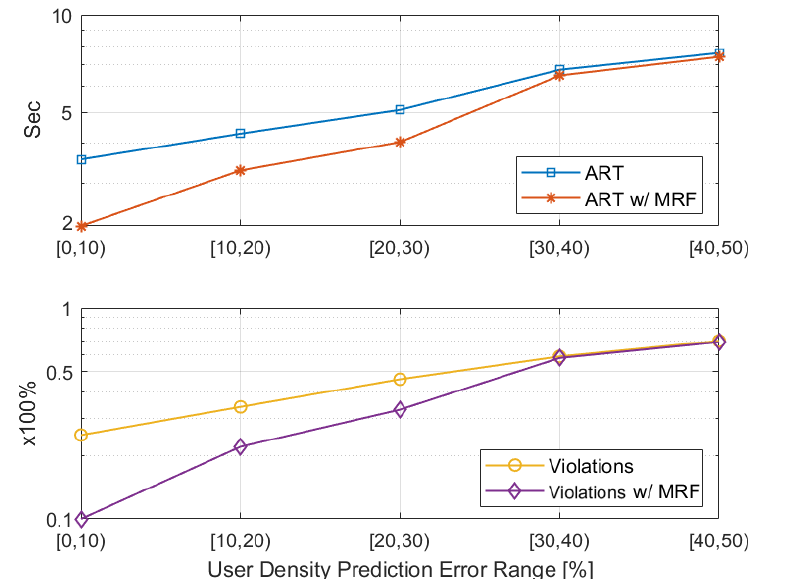
Figure 6. ART & QoS violations sensitivity to prediction